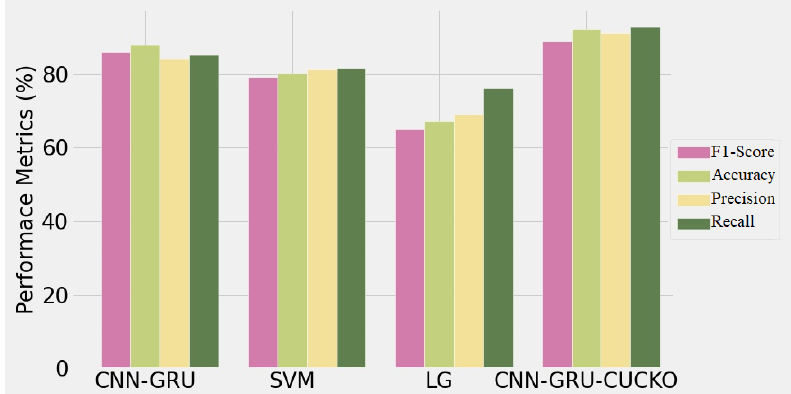
Figure 12. Performance evaluation results proposed vs.